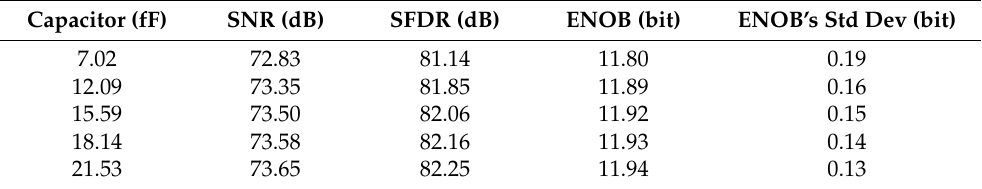
Table 1. The simulation results of the influence of capacitor